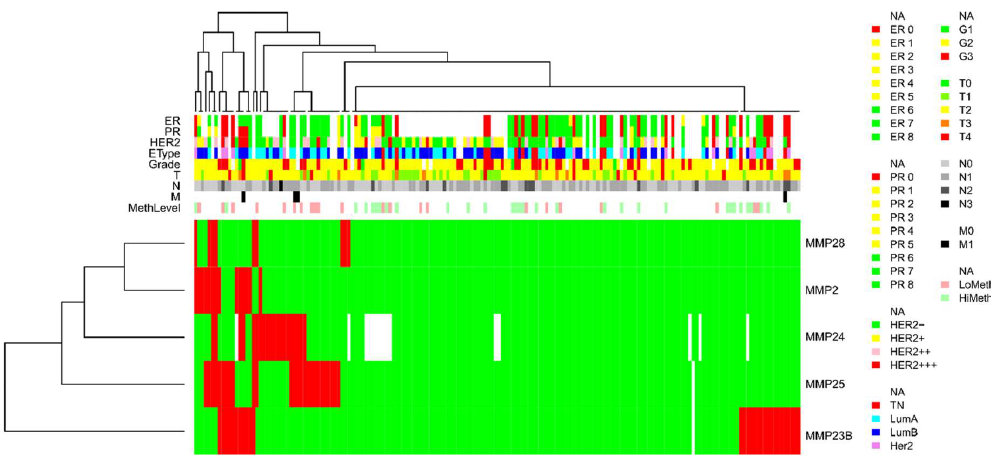
Figure 2. Cluster analysis of the DNA methylation data obtained for 183 breast cancer samples by methylation-sensitive restriction enzyme digestion PCR (MSRE-PCR) of the promoter CpG islands of the MMP2, MMP23B, MMP24, MMP25, and MMP28 genes. LoMeth and HiMeth (MethLevel track) are the moderately methylated and hypermethylated breast cancer (BC) subtypes previously assigned to 100 samples from the same tissue collection on the basis of a genome-wide DNA methylotyping [15]. The expression levels of the estrogen (ER) and progesterone (PR) receptors and the HER2 oncoprotein, breast cancer expression subtype (EType: TN, triple negative; LumA, luminal A; LumB, luminal B; and Her2, HER2 positive), tumor grade (G1–G3) and size (T0–T4), and regional lymph node (N0–N3) and distant (M0–M1) metastasis status are also indicated as colored rectangles along the corresponding tracks. The heat map demonstrates methylated (red) or nonmethylated (green) methylation statuses of the assessed promoter CpG dinucleotides of the matrix metalloproteinases (MMP) genes assayed in breast cancer samples.